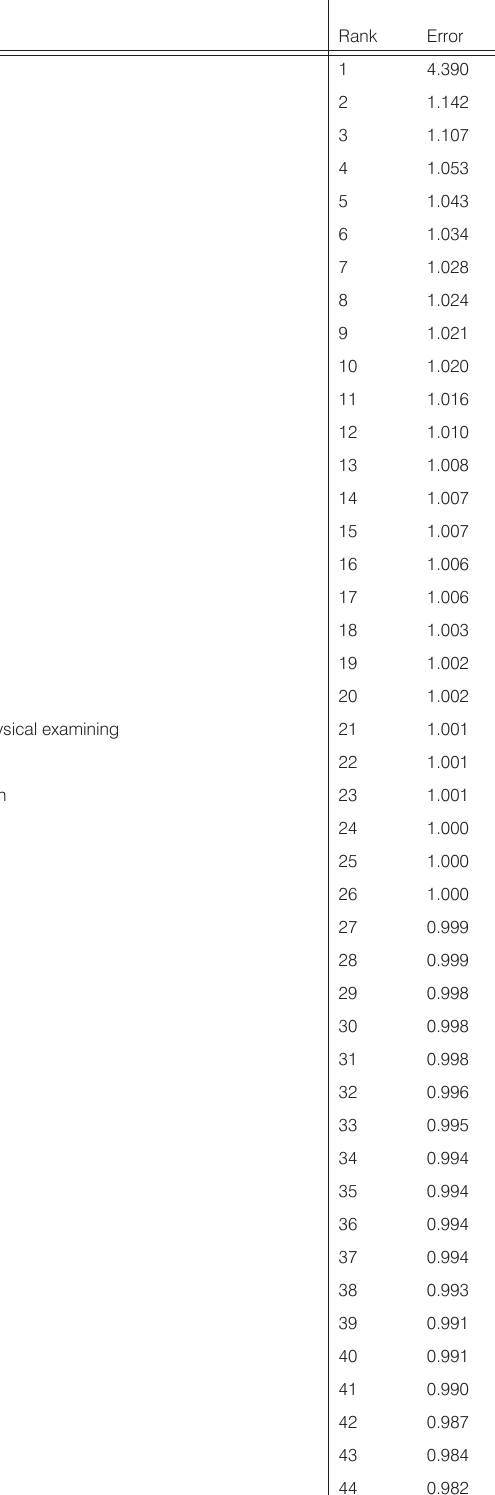
Table 6. Sensitivity analysis results for the variables used to estimate presence lung cancer in ANN